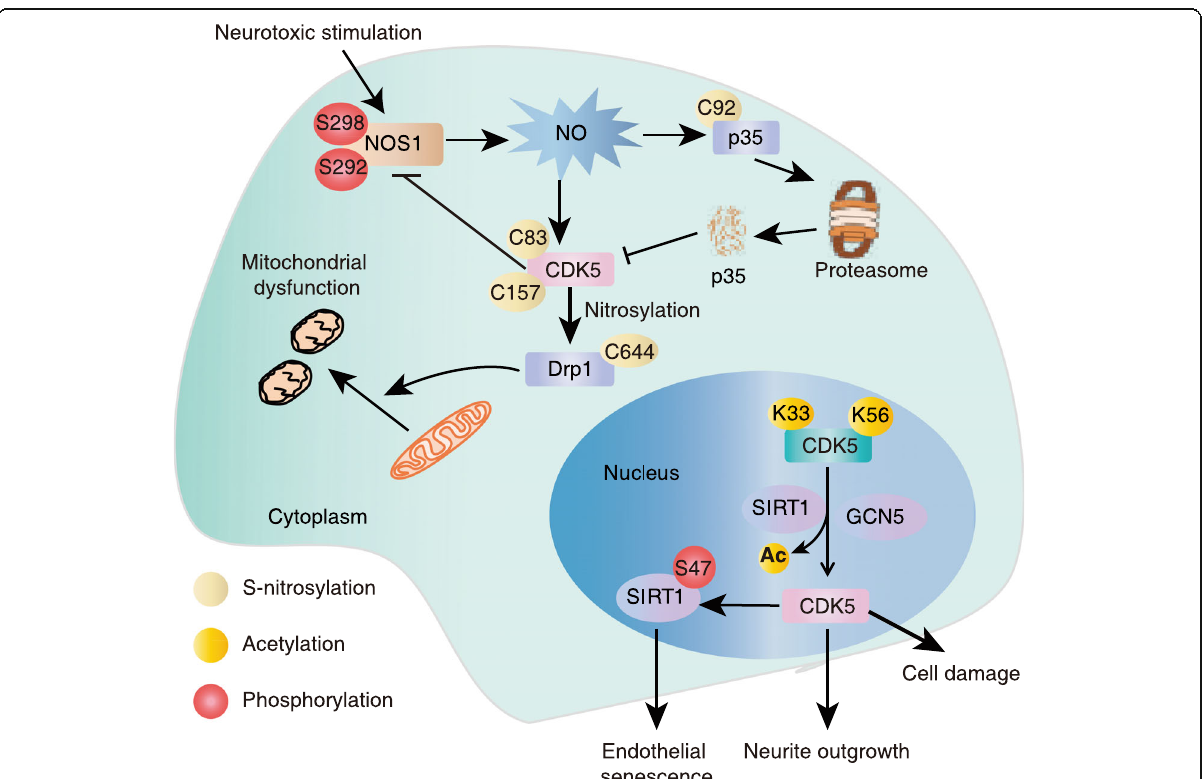
Fig. 4 S-nitrosylation and acetylation of CDK5 in cell. The interaction between NOS1 and CDK5 promotes the formation of SNO-CDK5, and then SNO-CDK5 may transfer NO group to DRP1 by transnitrosation, resulting in excessive mitochondrial division and subsequently mitochondrial dysfunction. SNO-CDK5 phosphorylates NOS1 on S292 and S298, creating a negative-feedback loop by suppressing NOS1 activity. In addition, NO is able to negatively regulate the activity of CDK5 by inducing p35 S-nitrosation at C92 for controlling the development of neuronal cells. In nucleus, the acetylation of CDK5 at K33 and K56 mediated by SIRT1 and GCN5 leads to the loss of ATP binding and the impairment of kinase activity, which regulates multiple cellular processes, including neurite outgrowth and cell damage. The activated CDK5 can in turn phosphorylate SIRT1 at S47 that contributes to cell